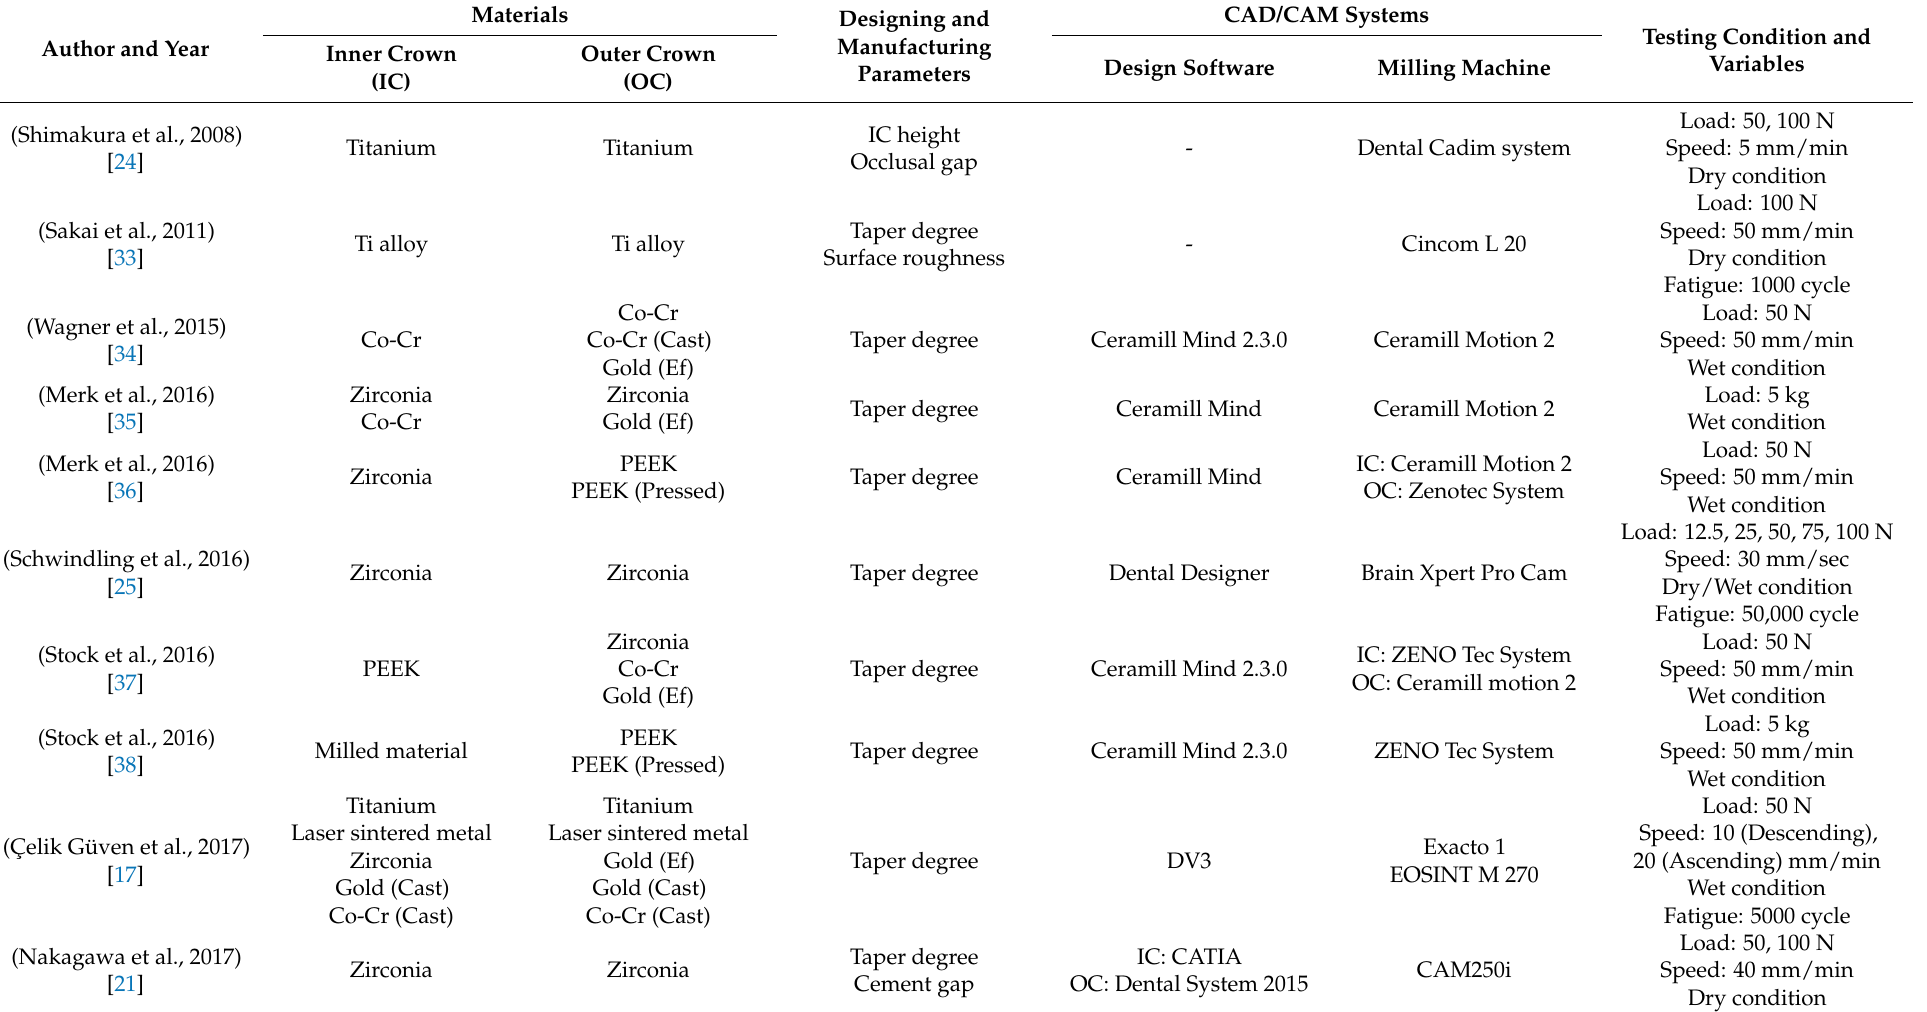
Table 1. Data extracted from selected